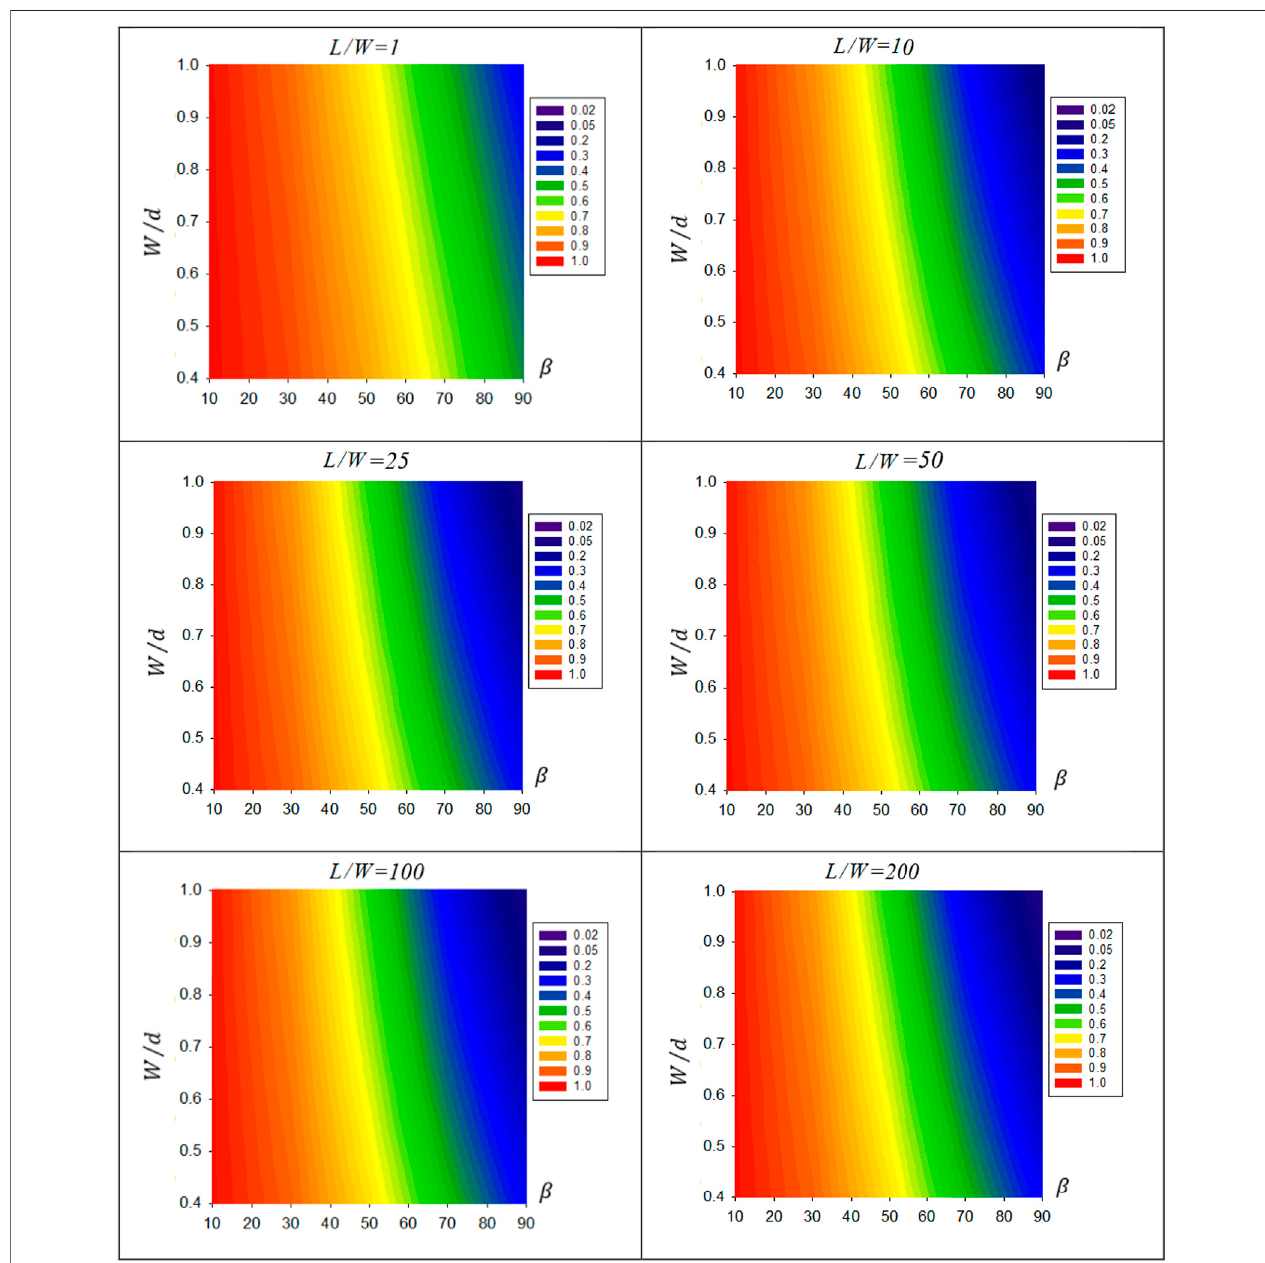
FIGURE 8 | Contour representation of F A